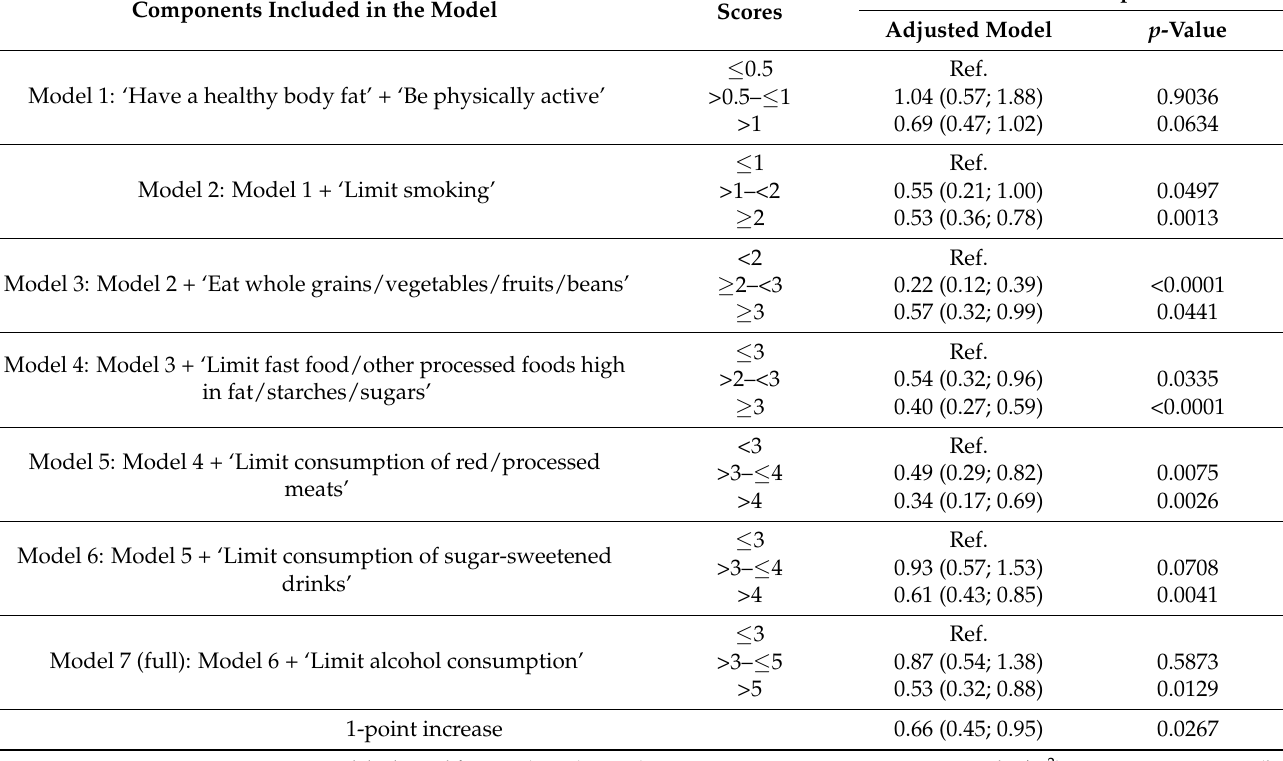
Table 8. Odds ratios (95% confidence intervals) of lung cancer occurrence for the combination of components of Ad-LC WCRF/AICR